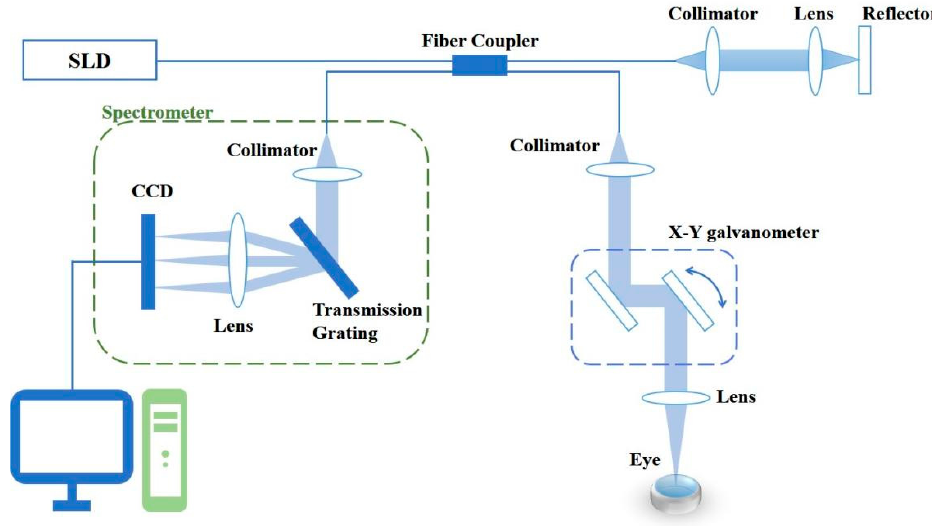
Figure 1. Schematic diagram of SD-OCT system.